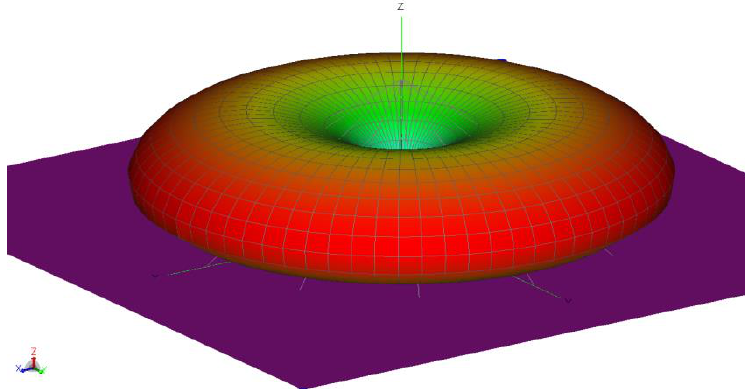
Figure 7. Antenna pattern .